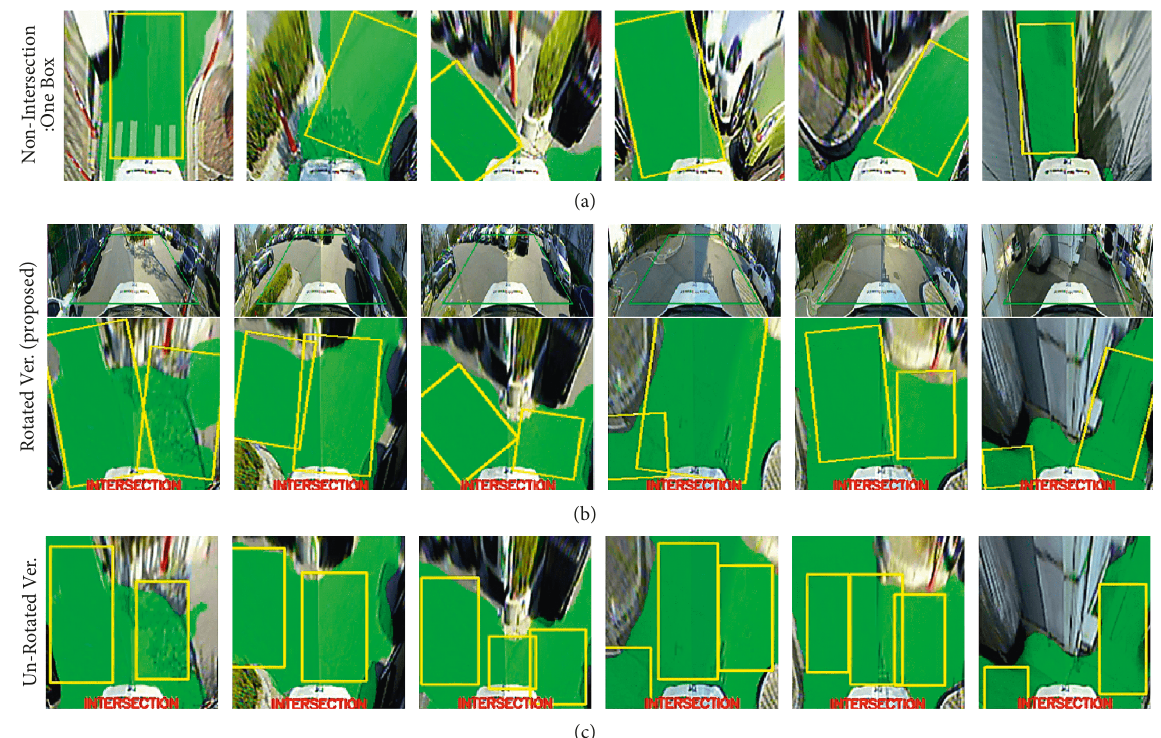
Figure 5: Rotated road bounding box detection results; (a) nonintersection case, (b) intersection case with rotated bounding box, and (c) unrotated bounding